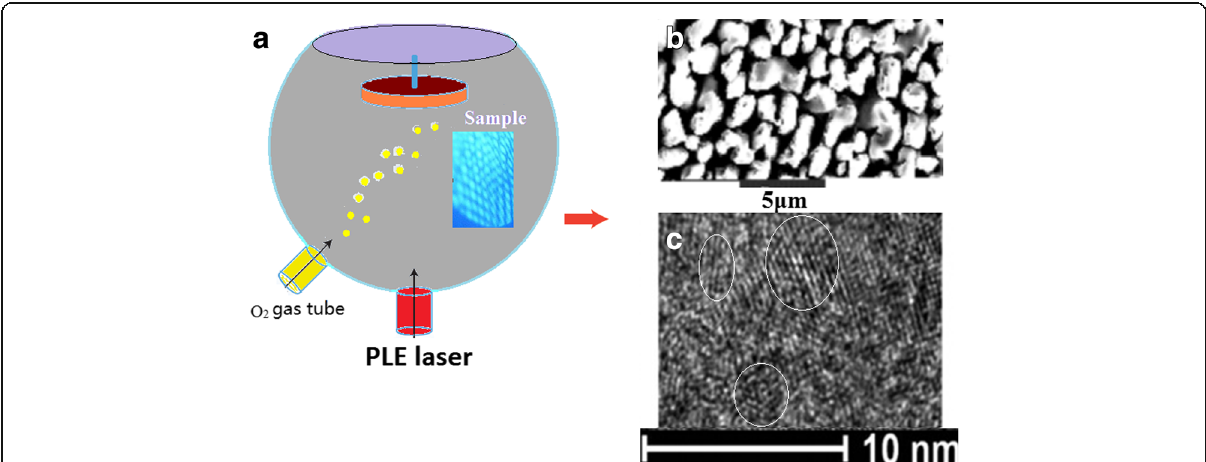
Fig. 1 a Structure depiction of PLE device used to fabricate the BS structures. b SEM image of the BS surface structure prepared by ns-laser after annealing. c TEM image of nanosilicon in the BS prepared by ns-laser after annealing